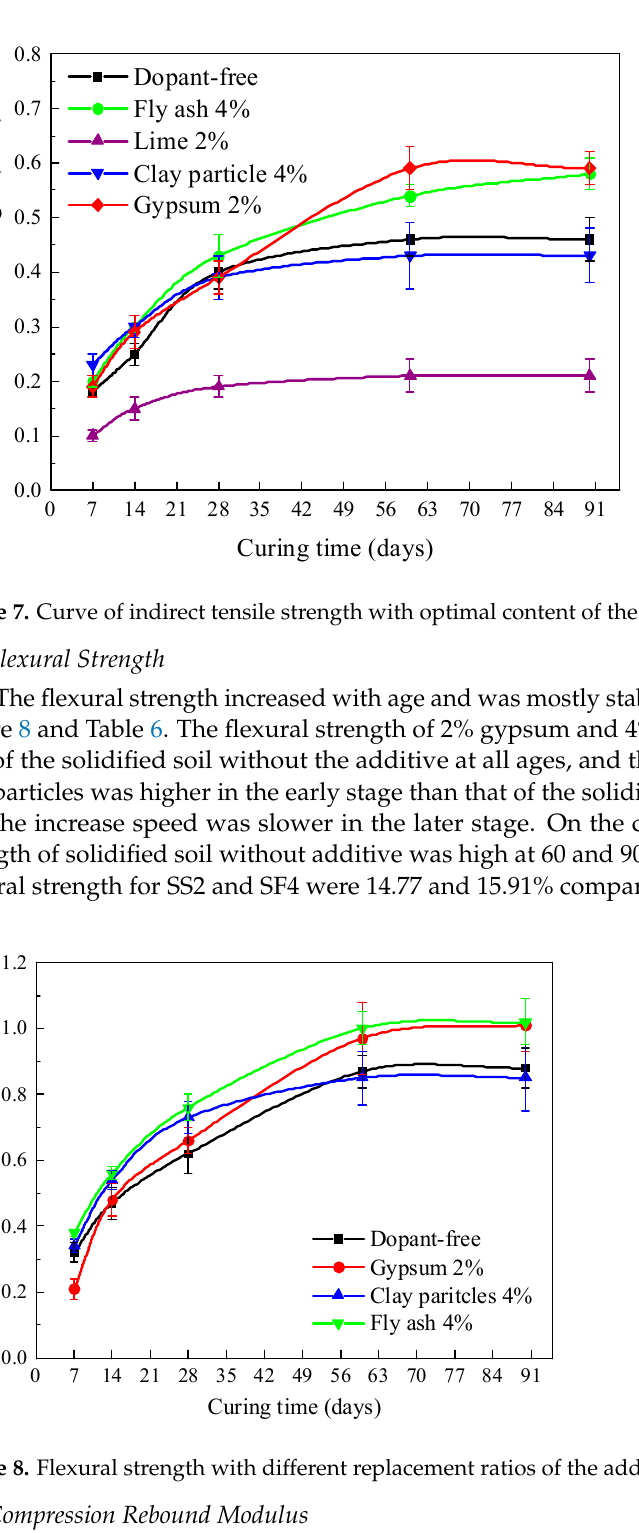
Figure 6. Curve of indirect tensile strength with different replacement ratios of the additives. Table 5. Test results for indirect tensile strength (MPa).